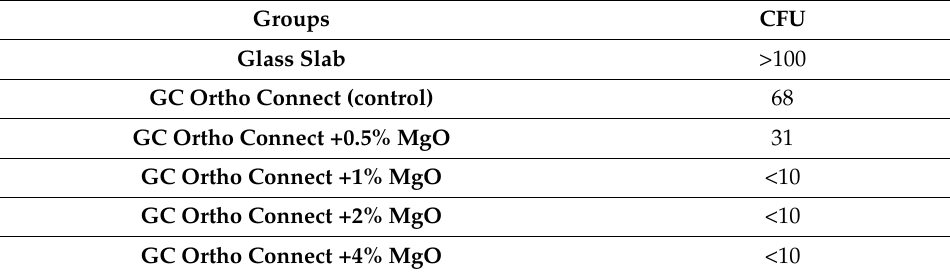
Table 3. The number of the colonies formed by S. mutans for each